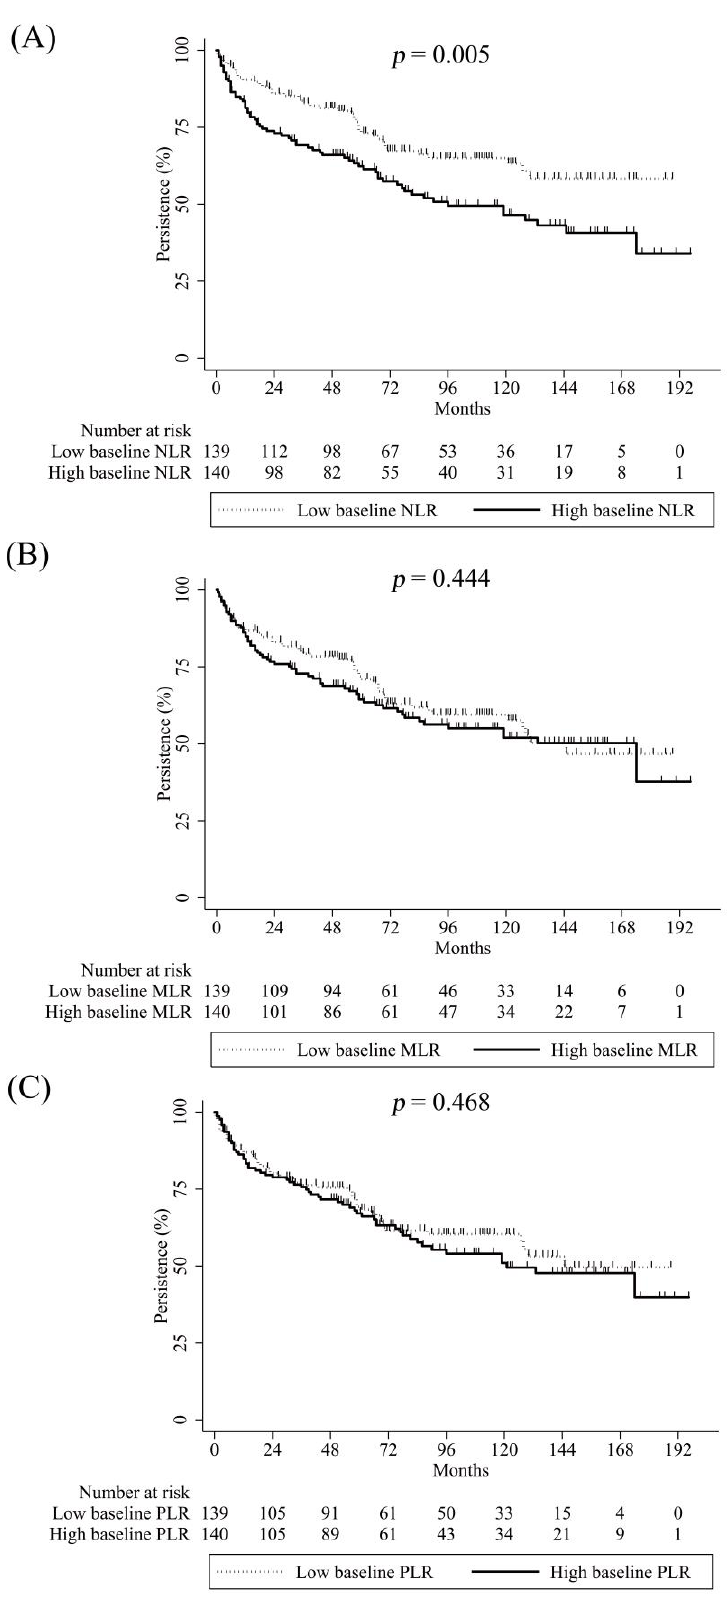
Figure 1. Comparisons of drug persistence of tumor necrosis factor-alpha blockers in patients with ankylosing spondylitis according to the baseline neutrophil-to-lymphocyte ( A ), monocyte-to-lymphocyte ( B ), and platelet-to-lymphocyte ratios ( C ).